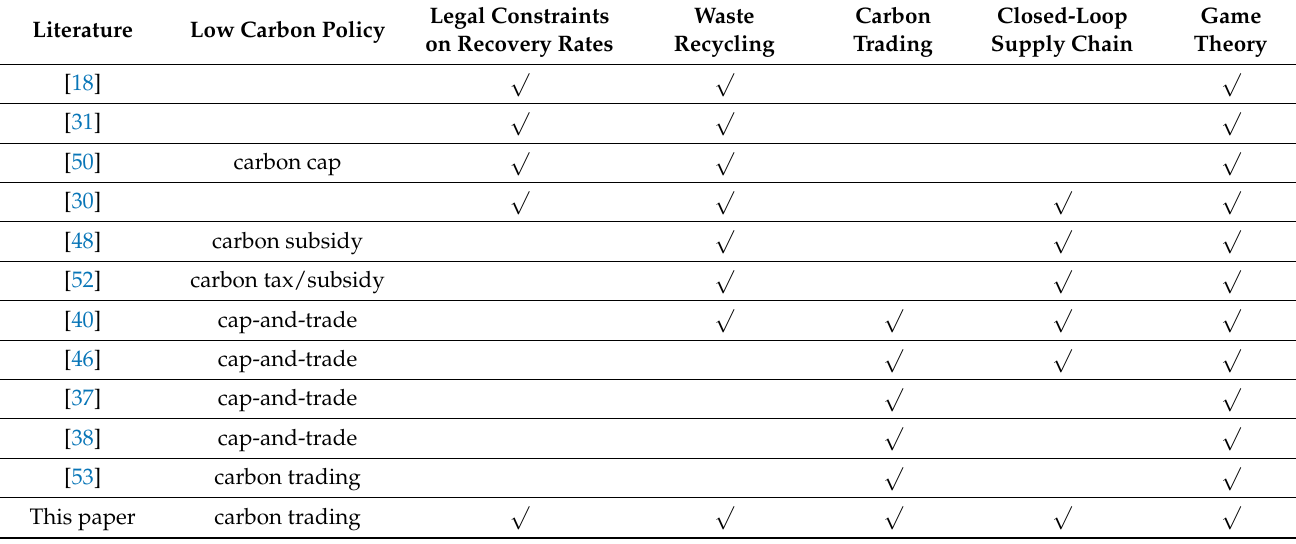
Table 1. The differences between this paper and other